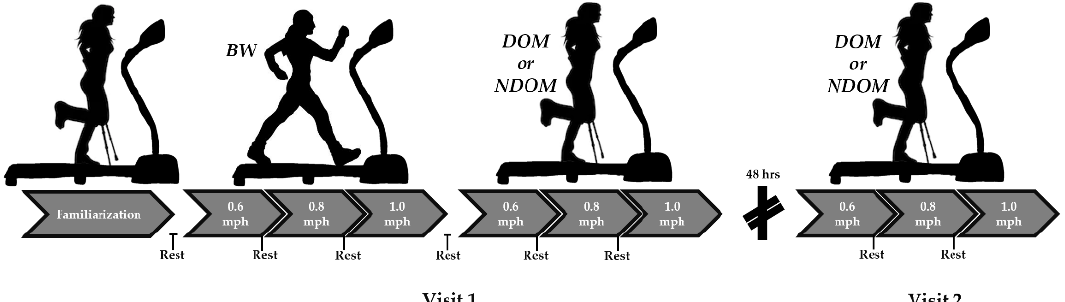
Figure 1. Study design. For visit 1, participants were familiarized with the axillary crutches followed by bipedal walking (BW). In a counterbalanced manner, participants then completed the dominant (DOM) or nondominant (NDOM) ambulation condition. Following a 48-h separation period, participants completed the 2nd visit, where they completed the final DOM or NDOM condition. For each treadmill bout, participants ambulated at 0.6, 0.8, and 1.0 mph phases. Each speed phase lasted 5 min. For all rest periods, participants sat until basal HR was reached before proceeding to the next phase. HR was monitored every minute, while sEMG was measured during the first 30 s and last 30 s of the speed phase.